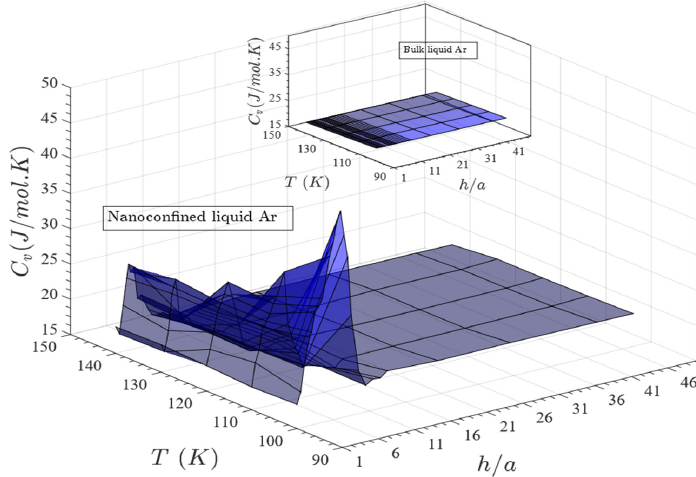
Figure 11. Heat capacity as a function of gap thickness and temperature.